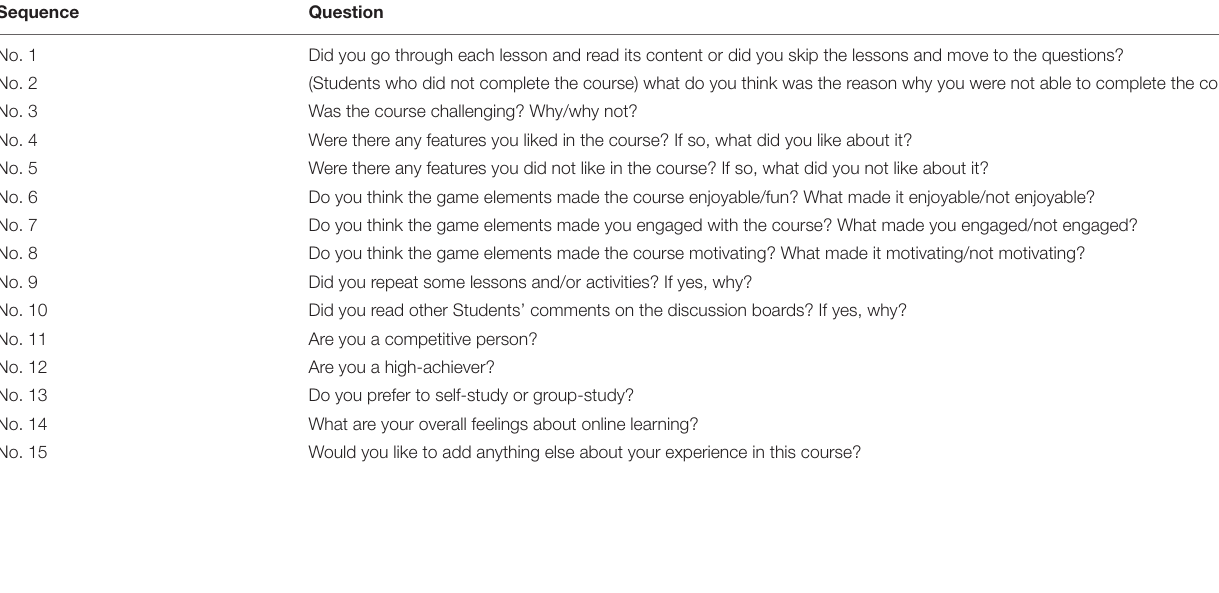
TABLE A1 | Semi-structured interview